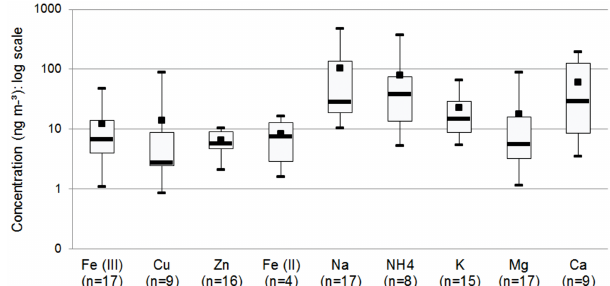
Figure 7. Box plot for the soluble ion and other species concen- trations in the total particulate matter samples at 60m height from 30 March to 25 April 2015. Upper and lower whiskers represent 1.5 interquartile ranges for the period; upper and lower boundaries are for the third and first quartile. The horizontal bar is the median value and the black square is the average value for each element. In the horizontal axis, the number of samples with valid results is